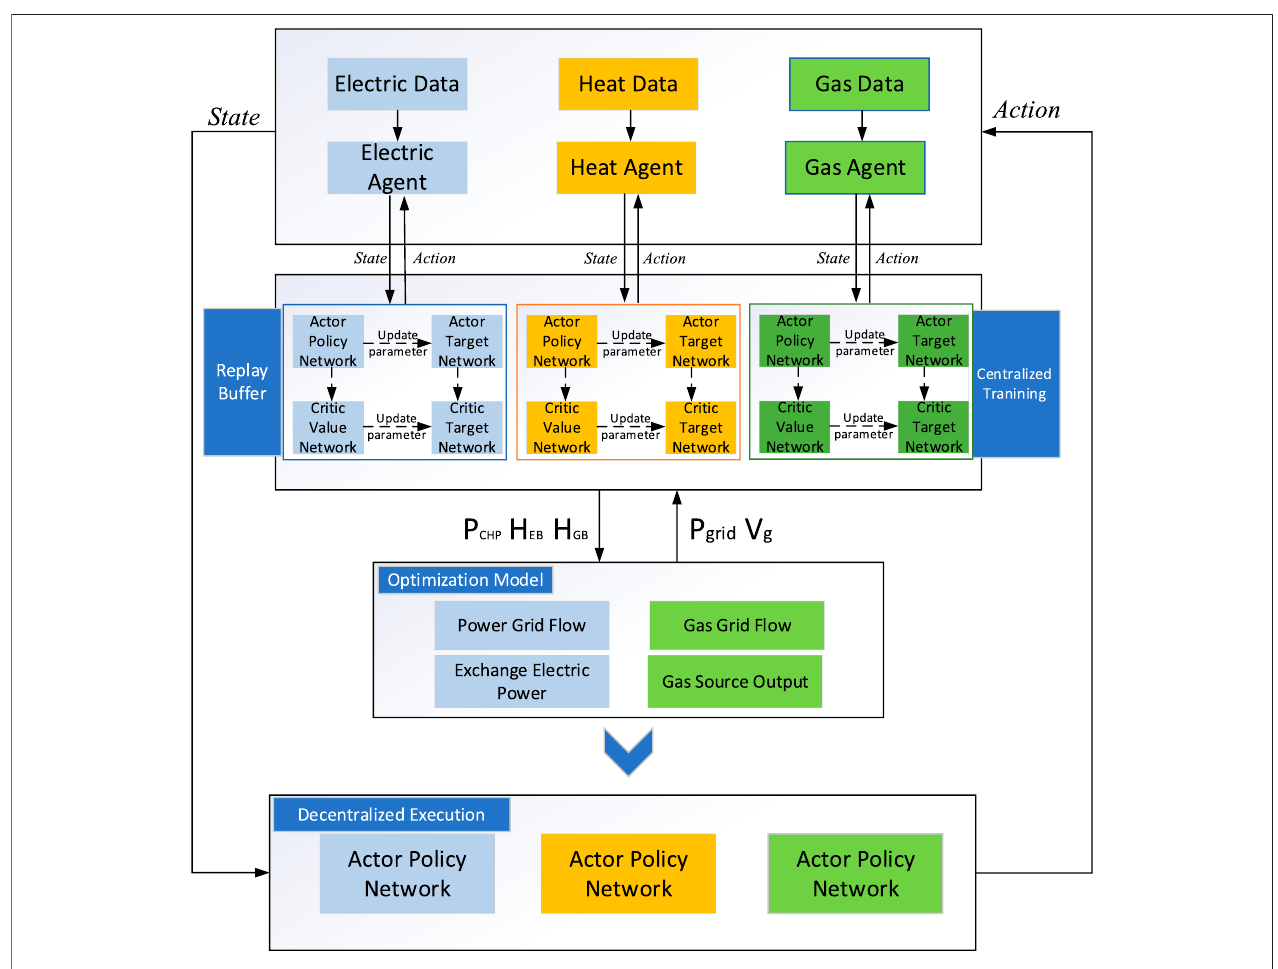
FIGURE 2 | The Two-level